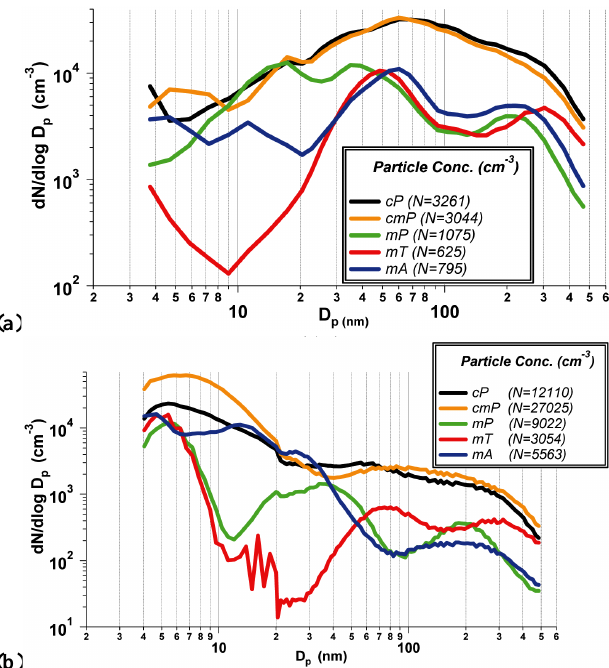
Fig. 7. (a) aerosol size distributions averaged by air mass and ex- cluding coastal nucleation events and (b) aerosol size distributions averaged by air mass during nucleation events. N in the key rep- resents total particle concentration per cm − 3 from sizes between